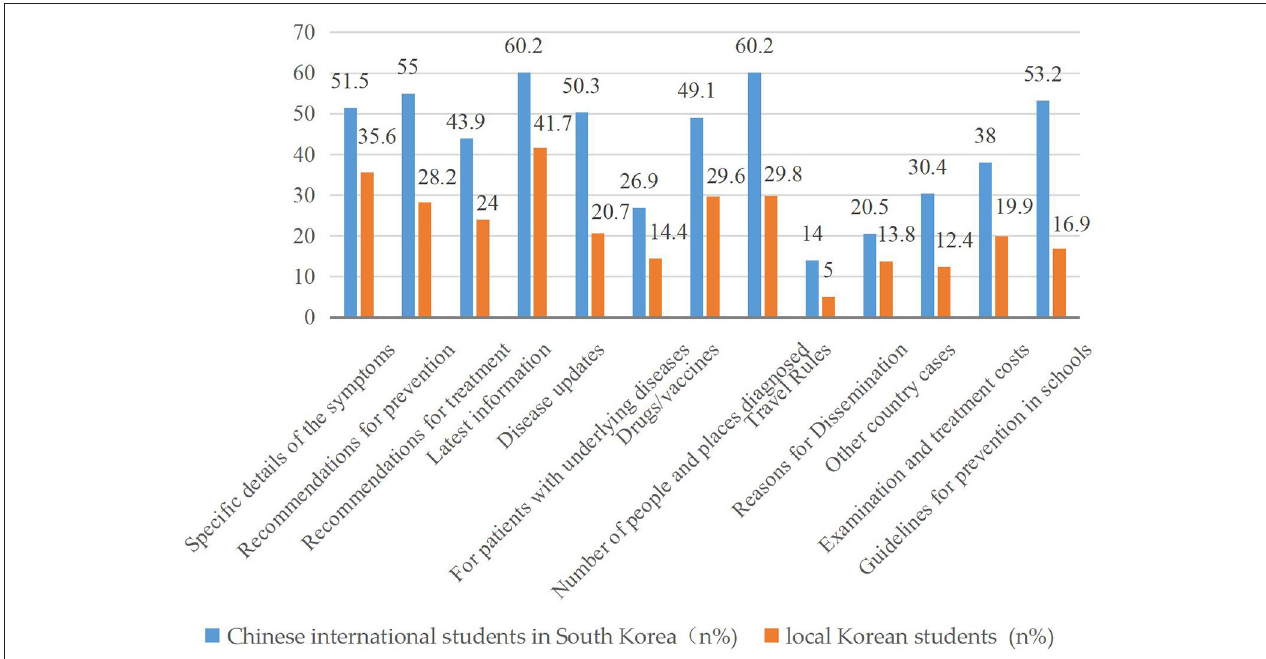
FIGURE 1 | Type of information expected between Chinese international students and local Korean students in South